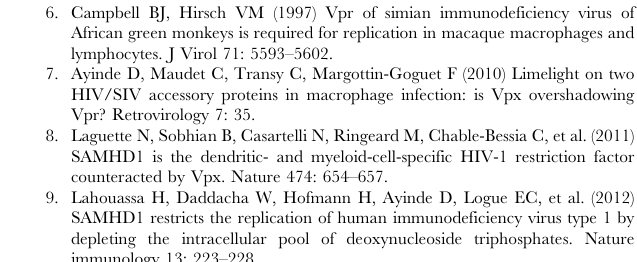
Figure S1 Complete predicted amino acid sequences for Vpx (S1a) and Vpr (S1b) derived from viral RNA sequences from plasma. Cullin 4 E3 binding region, required for counteraction of SAMHD1, is specified in sequence